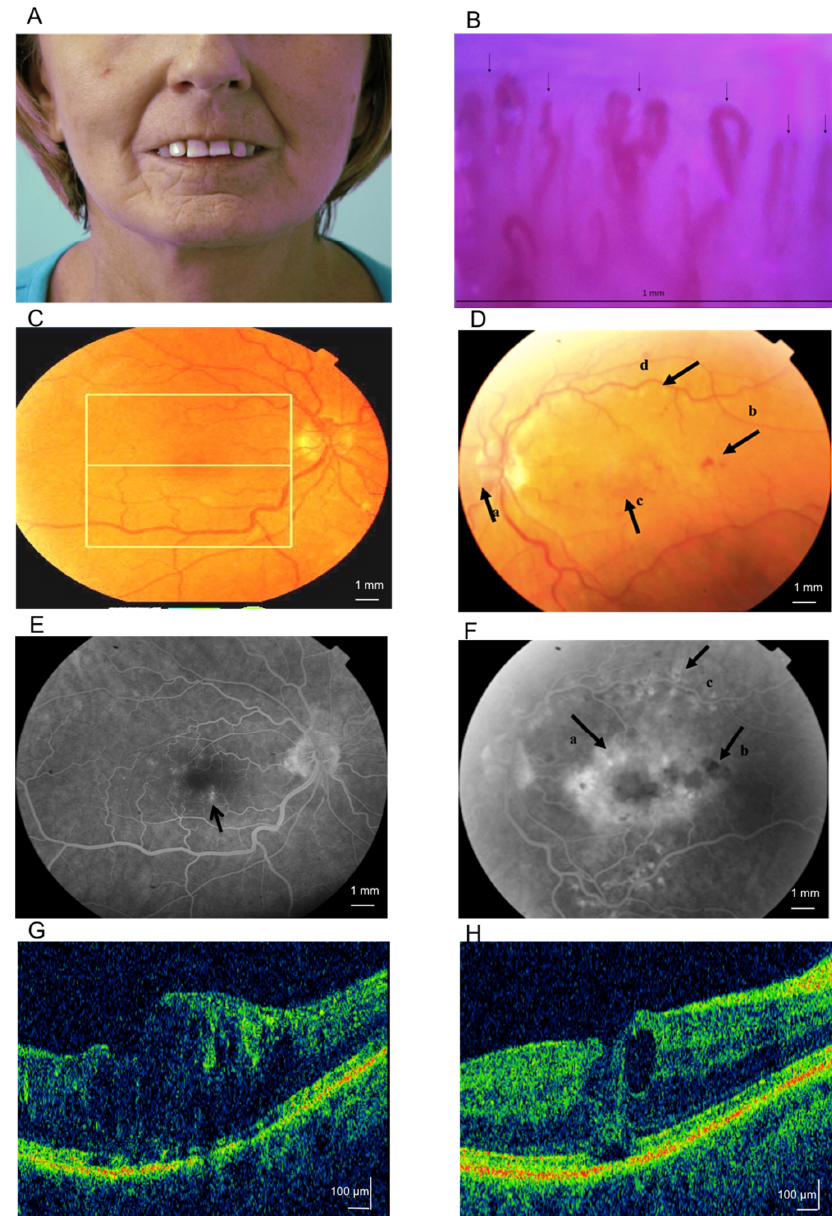
Figure 1. Patient 1, aged 51, diagnosed with systemic sclerosis (SSc) 6 years before the analysis. The image ( A ) shows mask-like facial appearance with characteristic pinched nose, radial furrowing around the mouth, lip thinning and retraction, microstomia, and one single teleangiectasia. ( B ) Nailfold videocapillaroscopy of active SSc pattern in the patient 1 with early desorganization of microvascular architecture; loss of capillaries with lowered density to six capillaries in linear mm; presence of dilated capillary ( > 20 µ m) with abnormal shape and ramification. The capillaries were marked with arrows. Images of right ( C , E , G ) and left ( D , F , H ) eye fundus of a patient 1, Data presented as fluorescein angiography (FA) versus optical coherence tomography (OCT). Color photo ( C ) and FA results ( E ) of the right eye fundus: in the recirculation phase, hyperfluorescence foci by a leakage from the microaneurysms can be observed (arrow). Color photo of the left eye fundus ( D ): vasodilation of the optical disc (a), intraretinal hemorrhages (b), macular edema (c), sectional narrowing of retinal vessels (d) may be noted. Results of fluorescein angiography of the left eye ( F ): di ff use macular leakage (a), foci of fluorescence blockade (b), laser photocoagulation scars (c) can be seen. Sclerodermic macular edema in right ( G ) and left eye ( H ) OCT